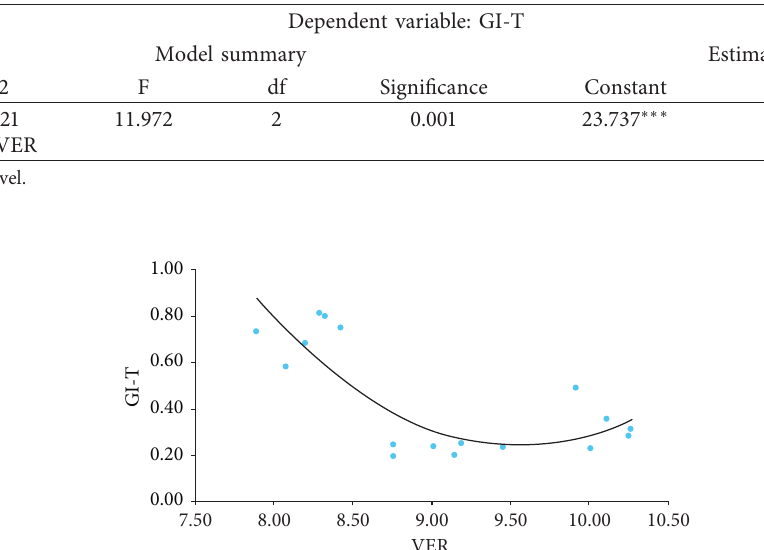
Table 8: Results of evolution relationship analysis on VER and GI-T.